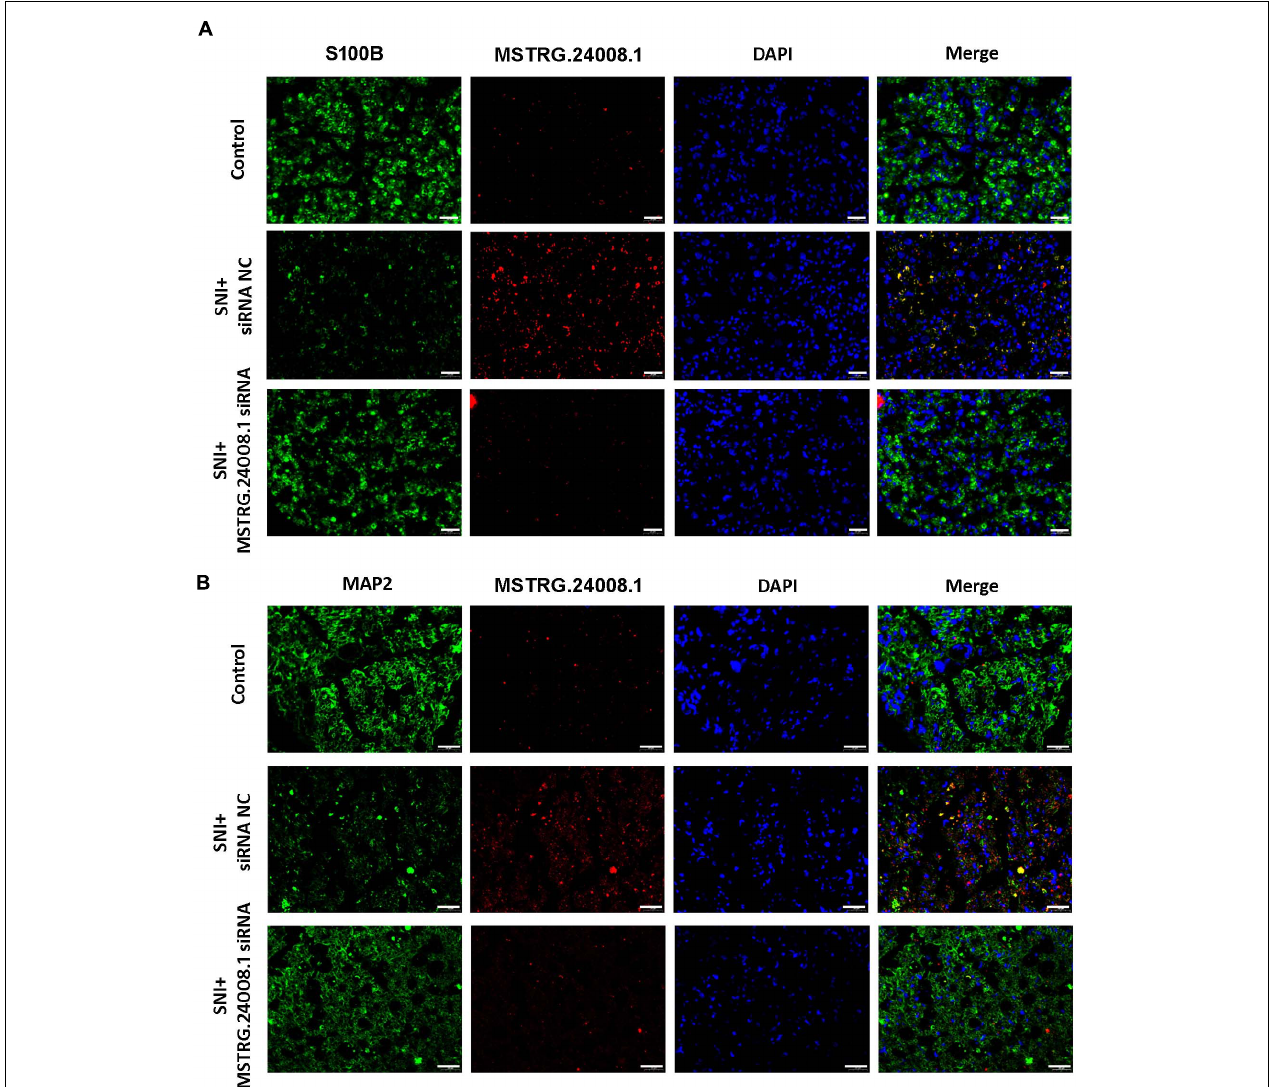
FIGURE 4 | The expression levels of S100B and MAP2 detected in SNI using fluorescence in situ hybridization. (A) Fluorescence in situ hybridization indicated that the expression of MSTRG.24008. 1 was significantly increased and that of S100B was significantly decreased in the SNI group compared with those in the Sham group; however, the expression of MSTRG.24008.1 was significantly decreased and that of S100B was significantly increased in the SNI group treated with the MSTRG.24008.1 siRNA compared with those in the SNI group. (B) Fluorescence in situ hybridization indicated that the expression of MSTRG.24008.1 was increased, and that of MAP2 was significantly decreased in the SNI group compared with those in the Sham group; however, the expression of MSTRG.24008.1 was significantly decreased and that of MAP2 was significantly increased in the SNI group treated with the MSTRG.24008.1 siRNA compared with those in the SNI group. Scale bar: 20 µ m (A,B)